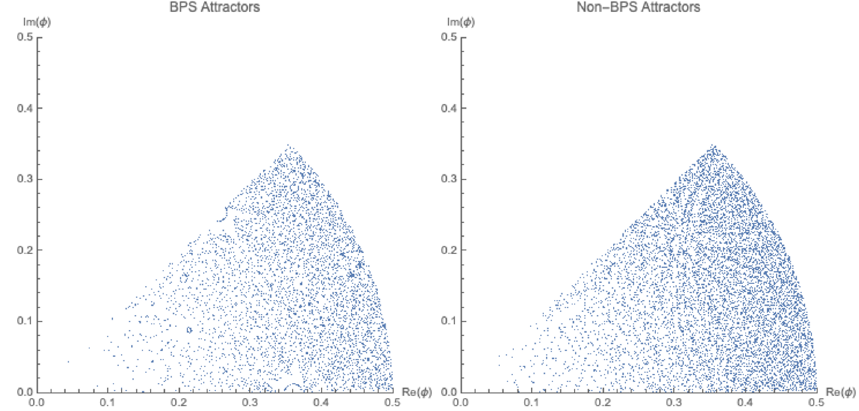
Figure 1 . Scatter plots of attractor moduli near the Landau-Ginzburg point. Our (cid:30) is the complex structure modulus of [29], for which a fundamental domain is 0 (cid:20) arg (cid:30) < 2 (cid:25)= 8.